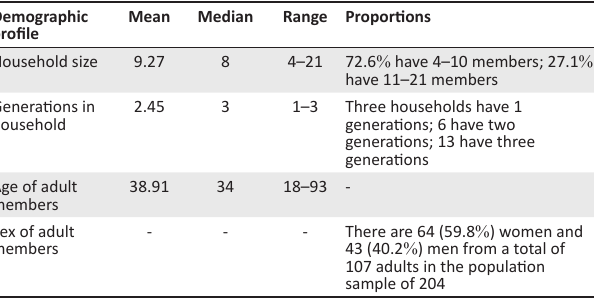
TABLE 2: Demographic features of households in Ncunjane ( n =